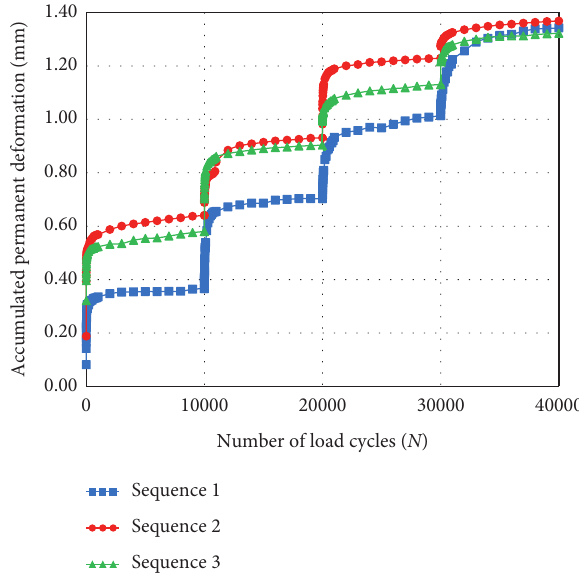
Figure 5: Accumulated permanent deformation as measured by the mixture RLT